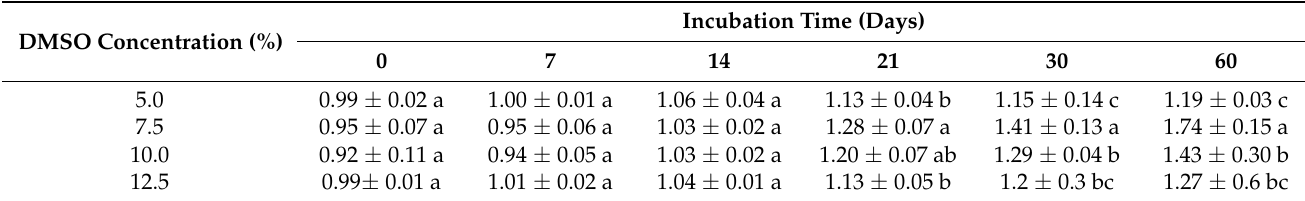
Table 7. Effect of DMSO concentration on the fresh weight of F. mandshurica embryogenic callus after cryopreservation by the slow cooling